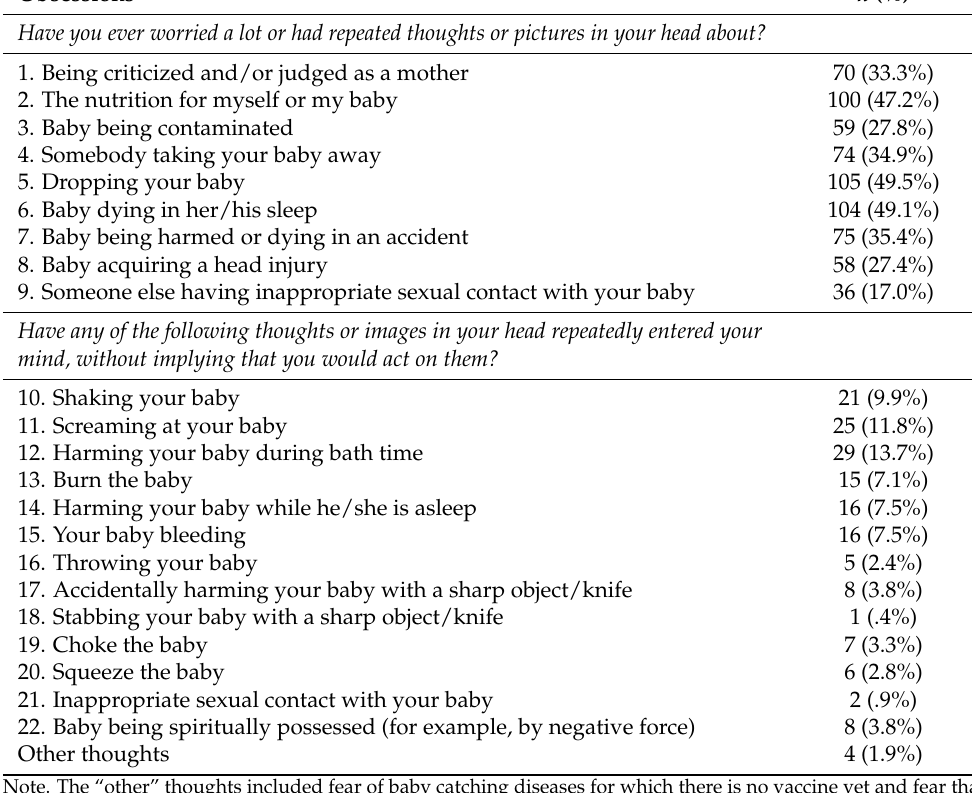
Figure 2. POCS ROC curve. Table 5. Prevalence of repeated thoughts or images in the postpartum considering total sample ( n = 212).